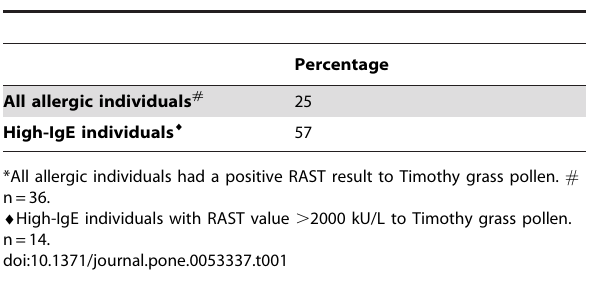
Table 1. Percentage of allergic individuals with IgE to the BGP coat